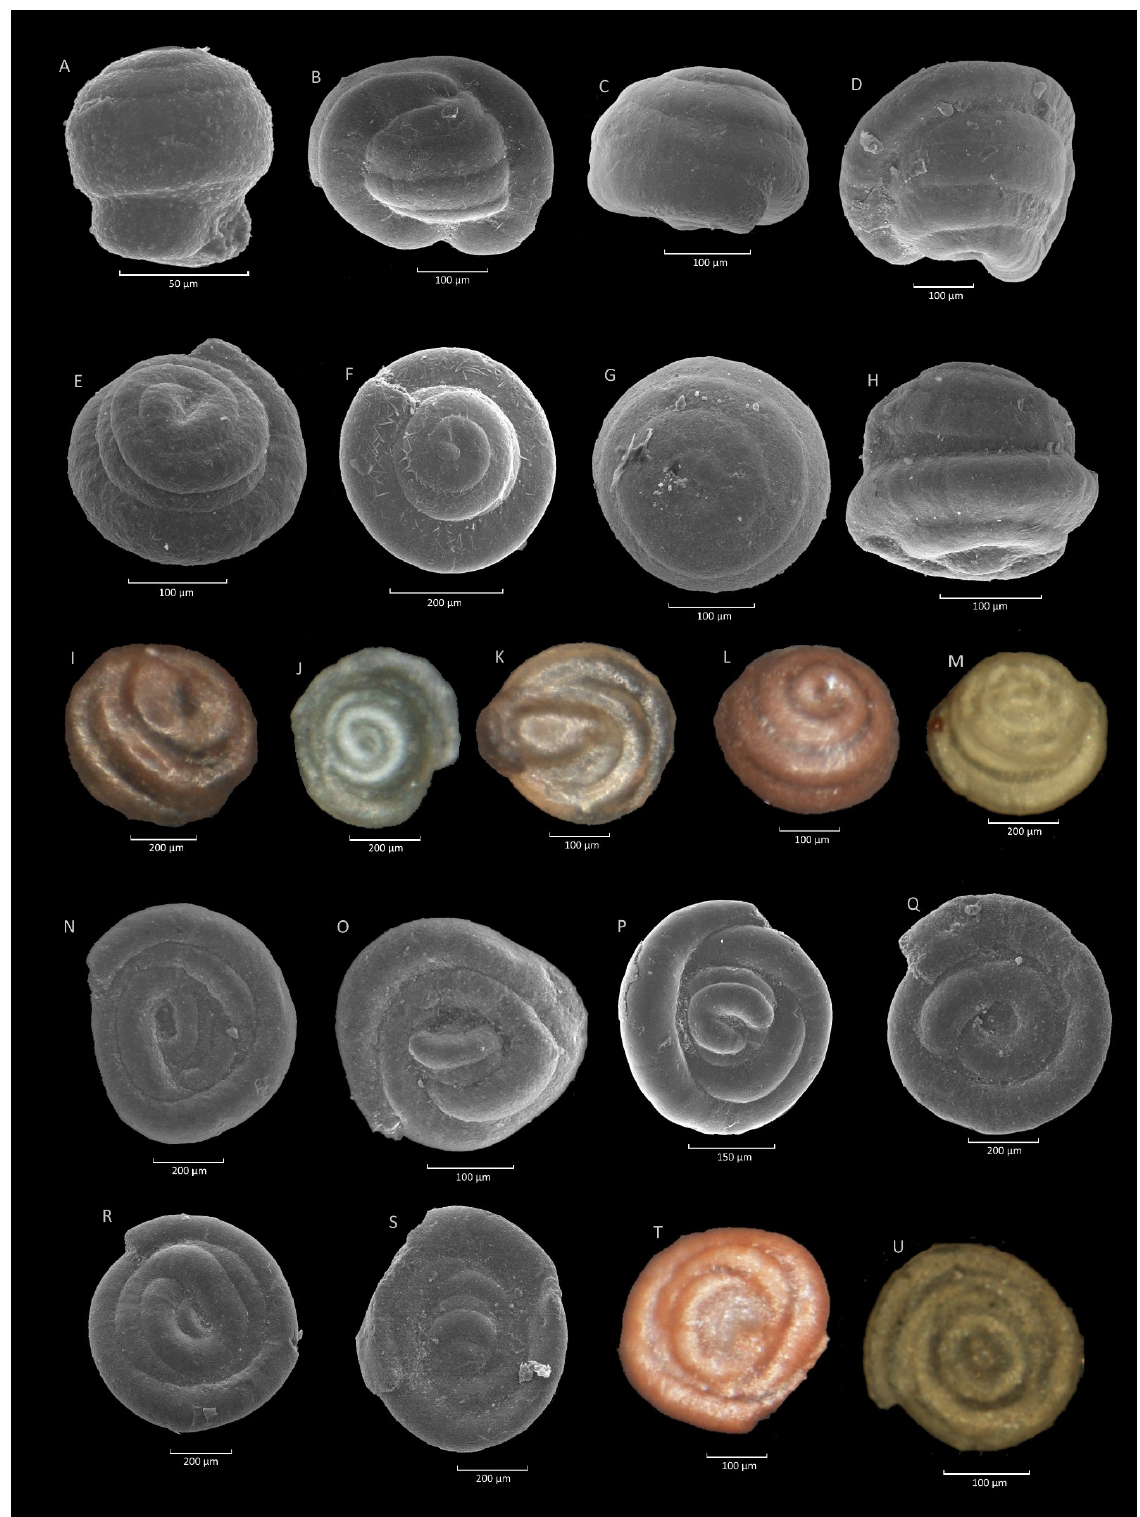
Figure 13. Glomospira charoides (Jones et Parker). ( A ): Czerwin section; ( B ): Krzesławice section; ( C ): Stradomka section; ( D ): Por˛eby-Czarnot ó wki section; ( E ): Sucha Beskidzka section; ( F ): Krzesławice section; ( G ): Mutne section; ( H ): Olecka section; ( I ): Gorlice section; ( J ): Olecka section; ( K , L ): Zamczysko section; ( M ): Klimk ó wka section. Glomospira gordialis (Jones et Parker); ( N ): Jezioro Ro˙znowskie section; ( O ): Lipie section; ( P ): Krzesz ó w section; ( Q ): Sucha Beskidzka section; ( R ): Rzyczki section; ( S ): Mutne section; ( T ): Zamczysko section; ( U ): Klimk ó wka